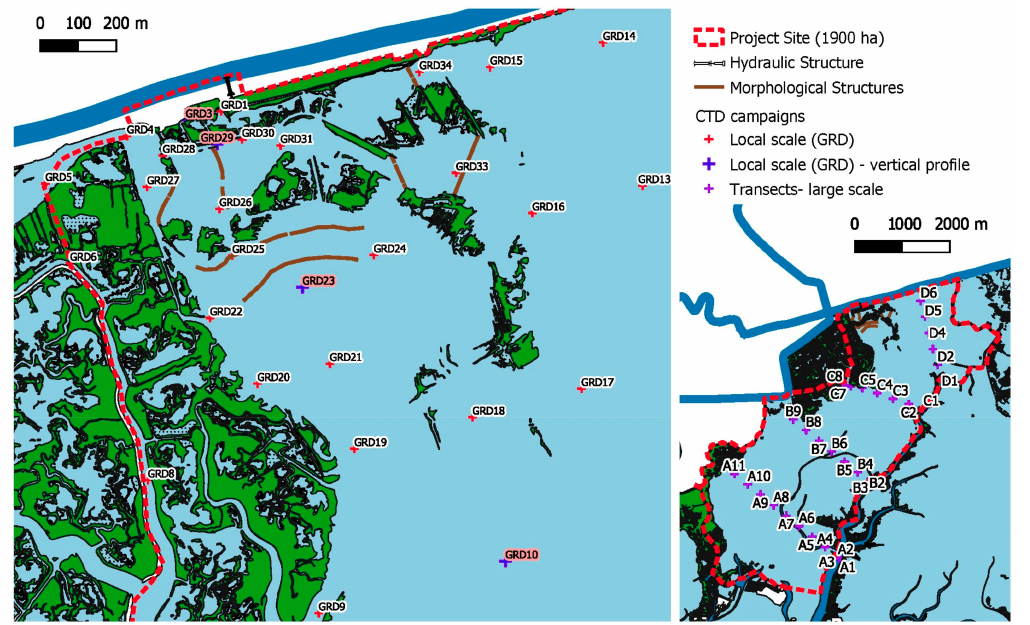
Figure 3. CTD campaigns: local and large scale strategies. Points with information relative to the complete vertical profile are also